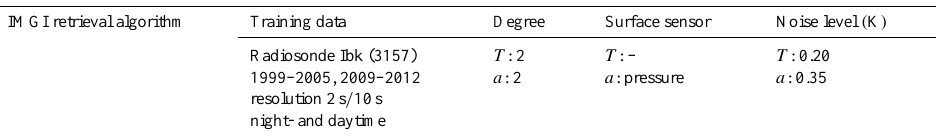
Table 3. Main characteristics of the improved retrieval (IMGI algorithm) for temperature ( T ) and absolute humidity ( a ). “Ibk” stands for the operational radiosonde at the airport of Innsbruck. “Degree” refers to the order of the employed regression (see Eq.